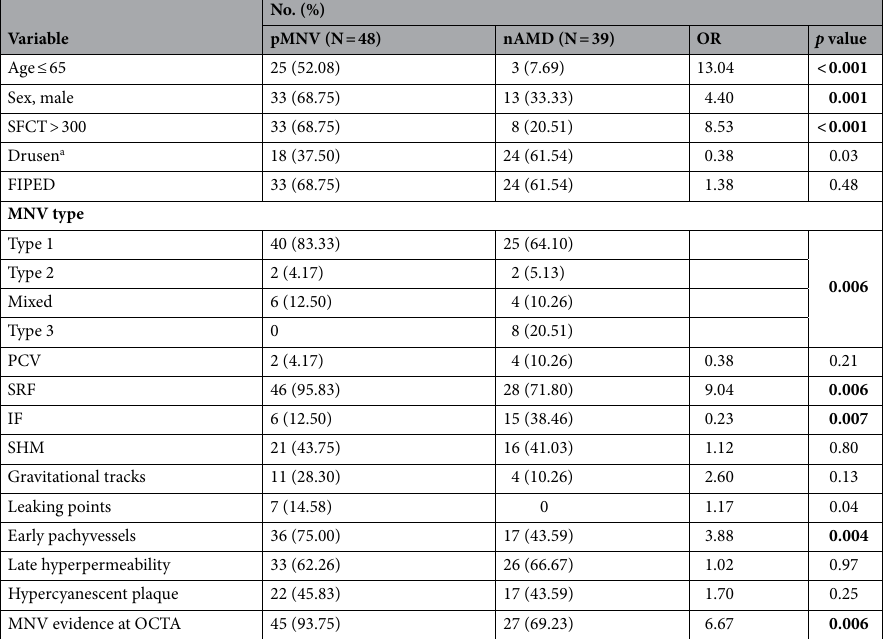
Table 2. Results of the univariate analysis. IF = Intraretinal fluid; OR = Odds Ratio; FIPED = Flat irregular pigment epithelium detachment; MNV = Macular neovascularization; nAMD = Neovascular age-related macular degeneration; OCTA = Optical Coherence Tomography Angiography; OR = Odds ratio; PCV = Polypoidal choroidal vasculopathy; pMNV = Pachychoroid disease complicated by MNV; SFCT = Subfoveal choroidal thickness; SHM = Sub-retinal hyperreflective Material; SRF = Sub-retinal fluid. a More than 6 drusen (> 63 μm each) in ETDRS grid. Significant values are in